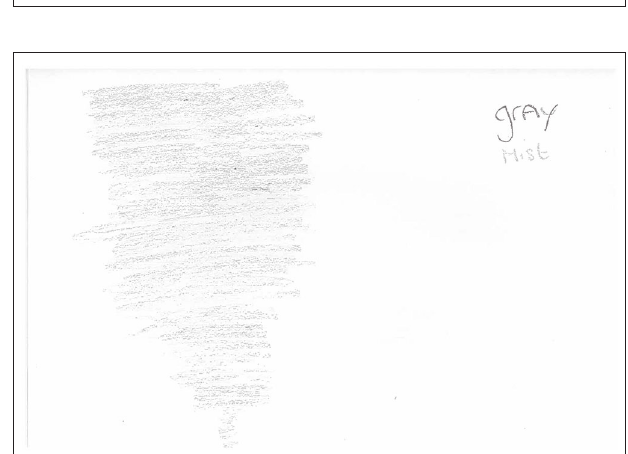
FIGURE 6 | WQ10 drawing of emotions experienced before